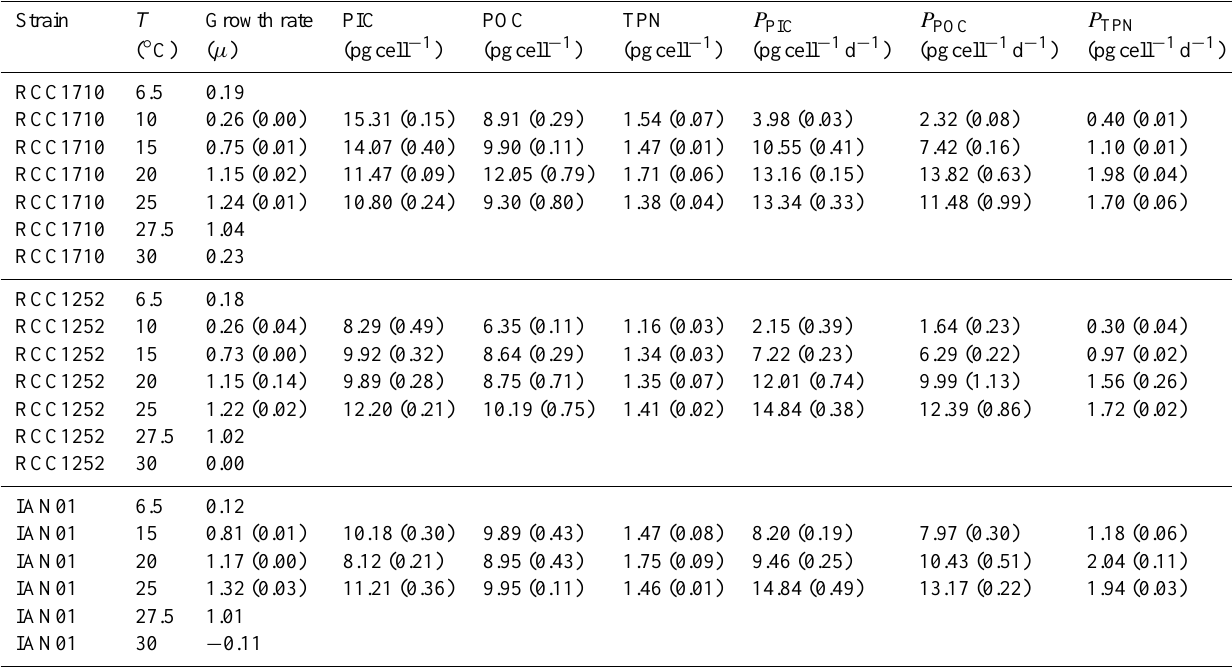
Table 1. Growth rate and cellular PIC, POC, and TPN content and production of the three strains of E. huxleyi at different temperatures. Standard deviation of the triplicates in parentheses. Measured growth rates for extra temperatures from the pre-experiments are included, but PIC, POC and TPN were not measured for these